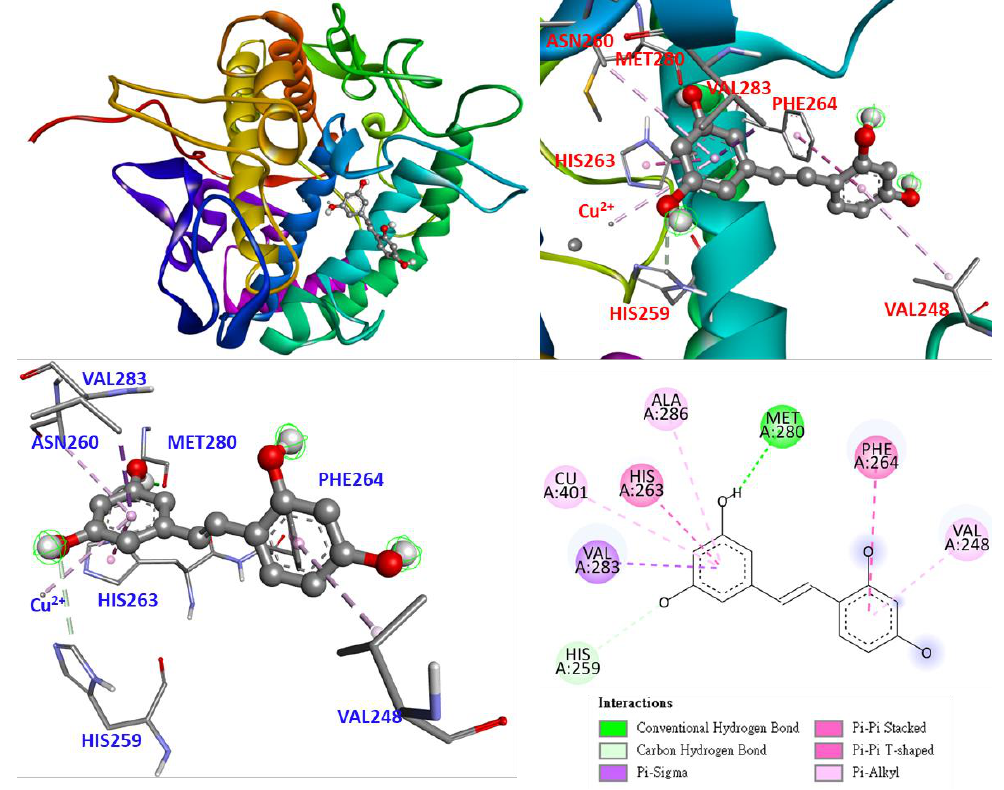
Figure 7. Interaction of oxyresveratrol ( 3 ) with active sites of Agaricus bisporus tyrosinase .